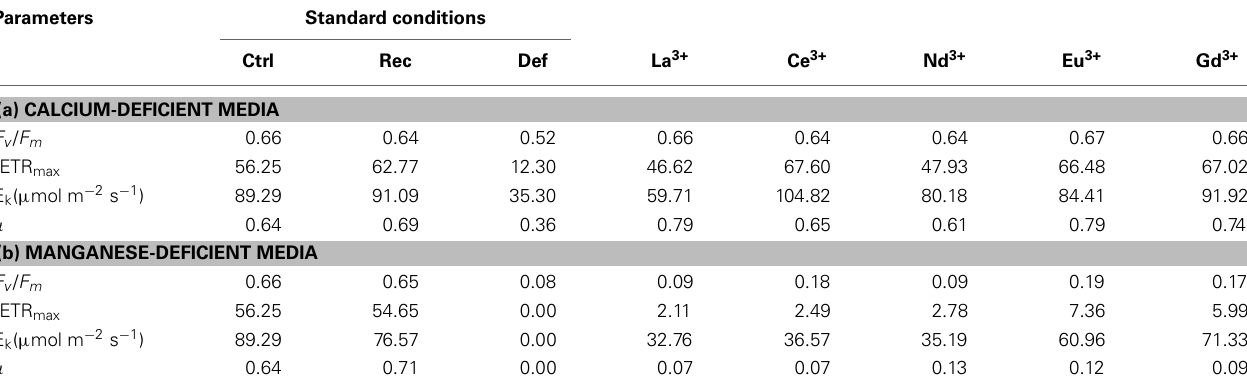
Table 5 | Summary of the physiological parameters of Desmodesmus quadricauda measured under replete conditions (standard medium as control, “Ctrl”) and under selective nutrient stress (deficient condition, “Def”: Ca 2 + -deficient media “a” and Mn 2 + -deficient media “b”).